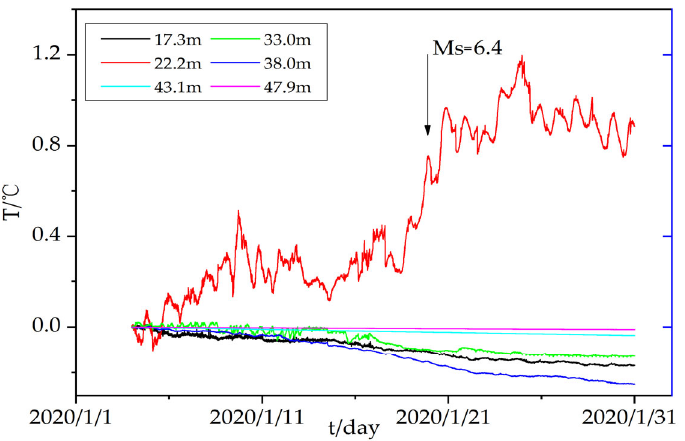
Figure 5. Geothermal time series of ground temperature in different layers at the GDL observation station.